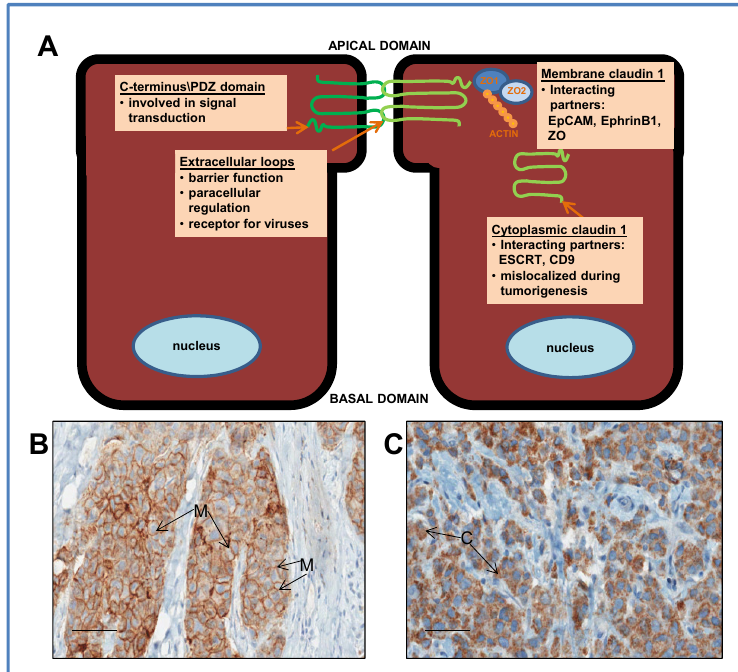
Figure 1. ( A ) Schematic representation of ductal epithelial cells, depicting the relative location and function of the claudin 1 protein in the membrane at the tight junction, and in the cytoplasm. The protein has 4 transmembrane domains with 2 extracellular loops with amino and carboxy terminal tails extending into the cytoplasm. The extracellular loops are essential for maintaining tight junction function, epithelial barrier integrity and regulating paracellular ion permeability. The C -terminus interacts with many signaling pathways through a PDZ domain. Through this domain, claudin 1 interacts with other tight junction proteins such as zona occludins (ZO). In addition to a tight junction function, membrane claudin 1 may act as a tumor facilitator by promoting collective migration during breast cancer progression; ( B ) Immunostaining of a breast tumor with claudin 1 antibody depicting membrane (M) staining and ( C ) depicting cytoplasmic (C) staining. Bars = 50 µ m.